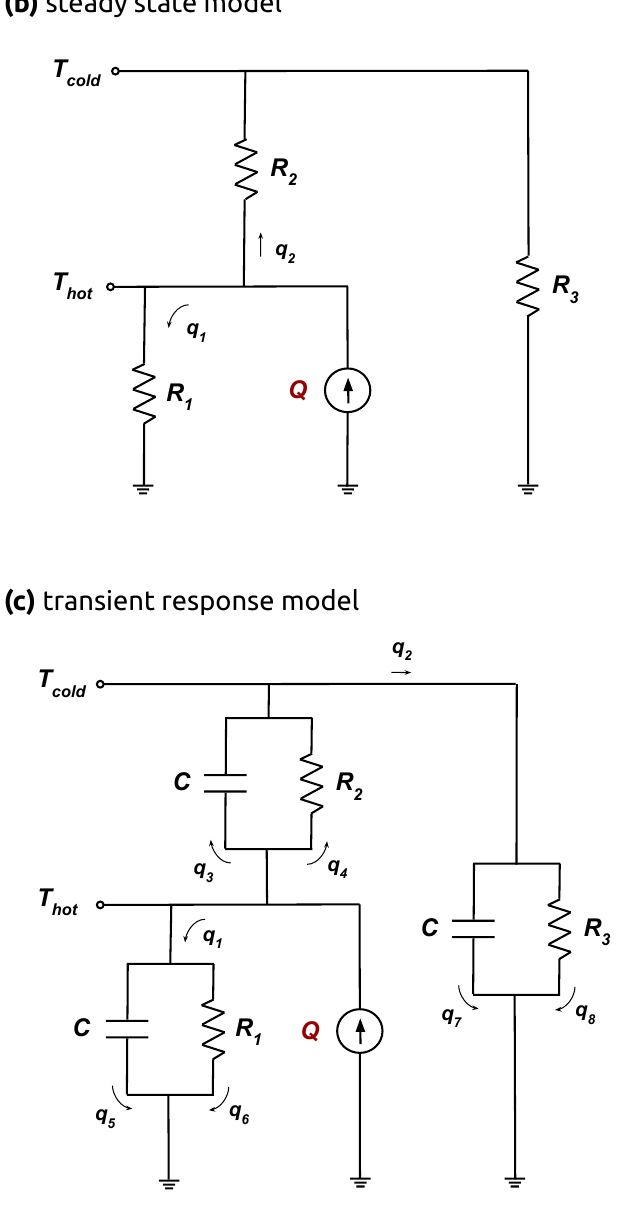
Figure 6. Complete thermal system model: ( a ) system scheme; ( b ) steady state thermal circuit; ( c ) transient thermal